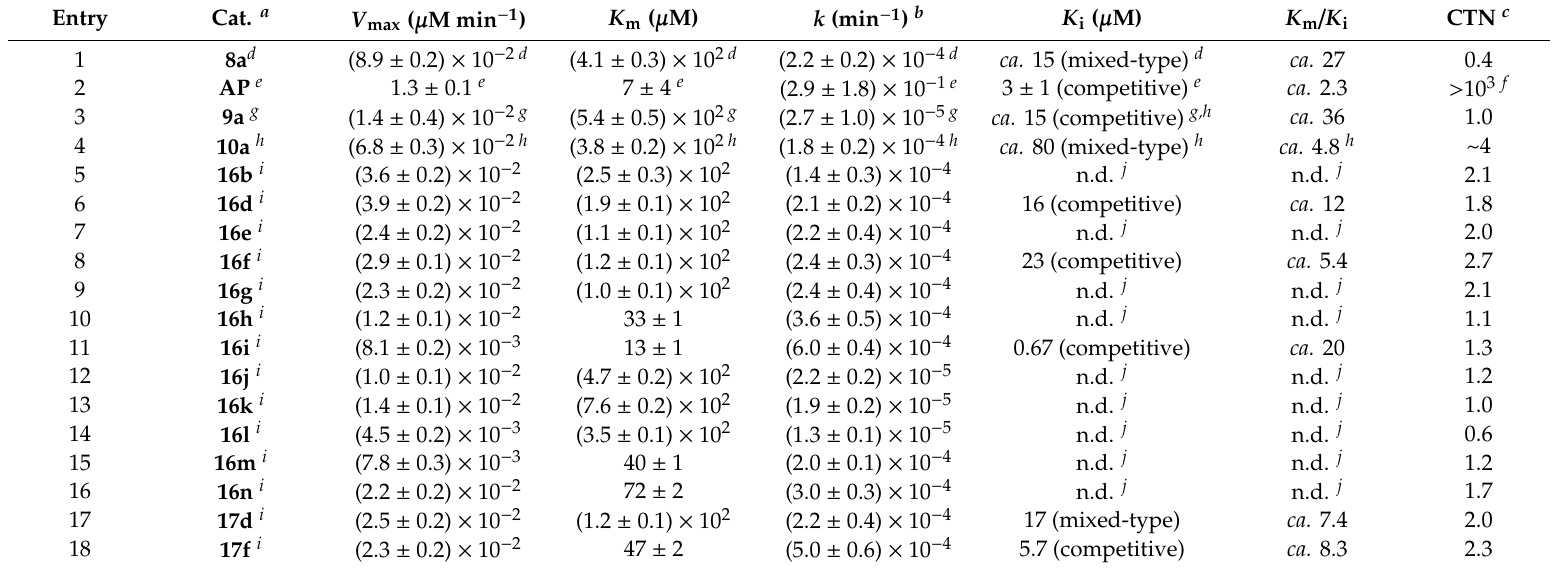
Table 2. Kinetics parameters for the hydrolysis of MNP by 8a and AP in single-phase solvent system (10 mM HEPES bu ff er (pH 7.4) with I = 0.1 (NaNO 3 )) at 37 ◦ C, and 9a , 10a , 16b , 16d – n , 17d , and 17f in two-phase solvent system (CHCl 3 / 50 mM HEPES bu ff er (pH 7.4) with I = 0.1 (NaNO 3 ) (2 / 8)) at 37 ◦